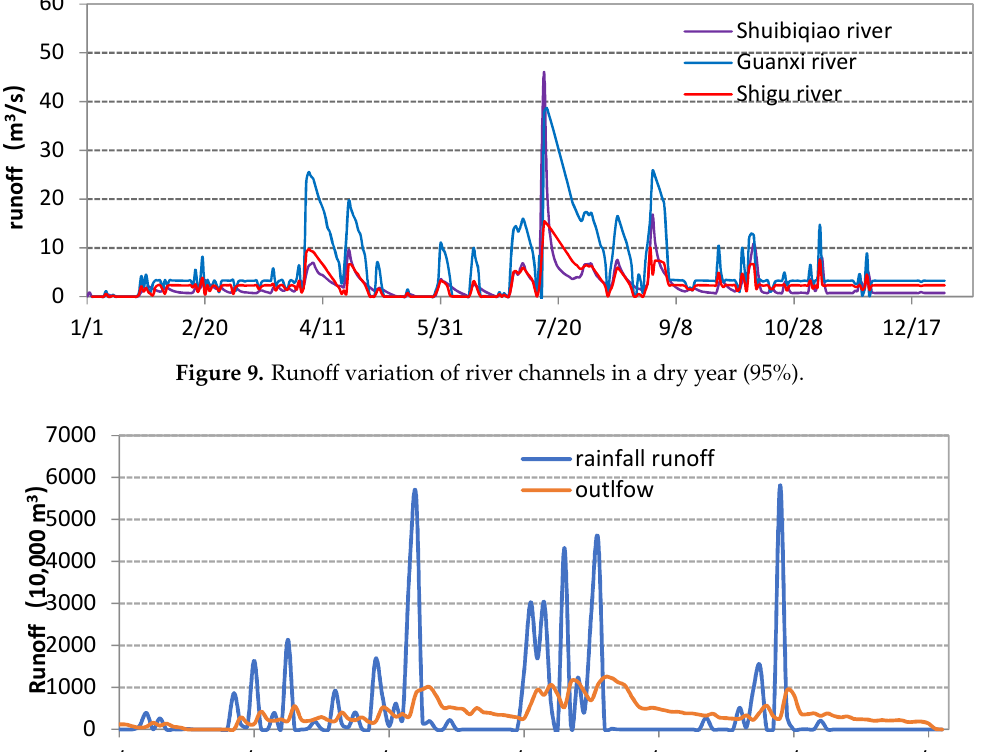
Figure 8. Runoff variation of river channels in a normal year (50%).